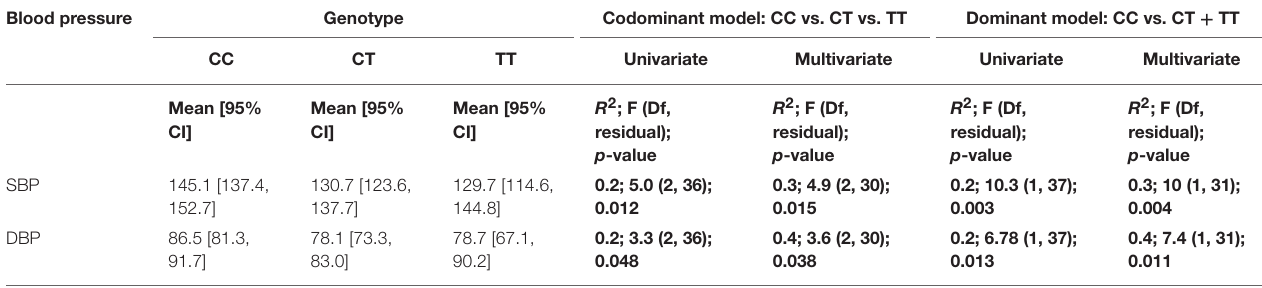
TABLE 2 | Association of ABCB1 polymorphism (rs1045642; CC vs. CT + TT) with systolic and diastolic blood pressure 1-year after kidney transplantation. Blood pressure